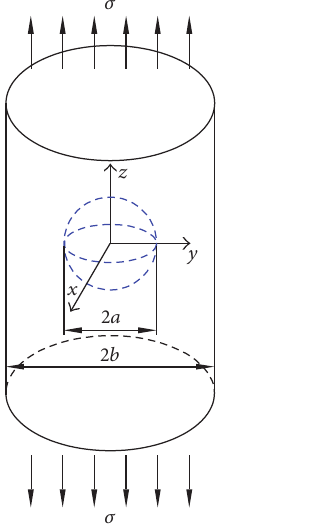
Figure 2: A circular cylinder with a center spherical cavity.